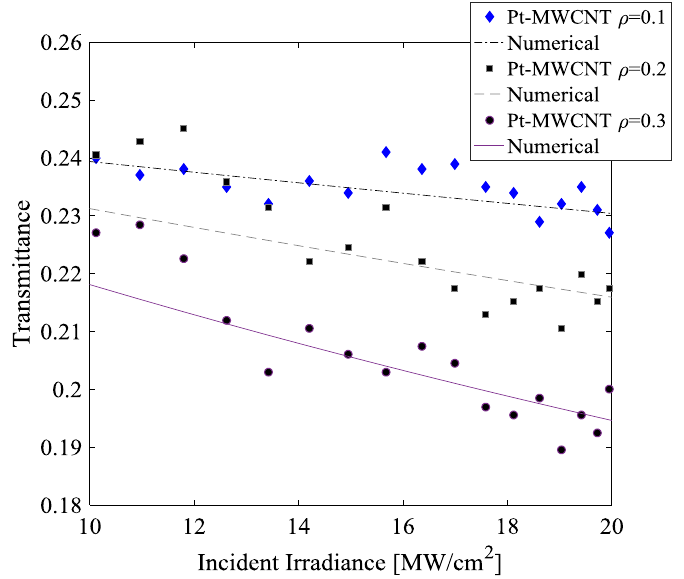
(3) Figure 6. Magnitude of  as a function of a change in the volume fraction of nanoparticles of Pt Figure 6. Magnitude of χ ( 3 ) as a function of a change in the volume fraction of nanoparticles of Pt decorating MWCNT in a sample in film form. decorating MWCNT in a sample in film Table 1. Nonlinear optical parameters evaluated in nanohybrids studied at a 532 nm and 4 ns pulses.